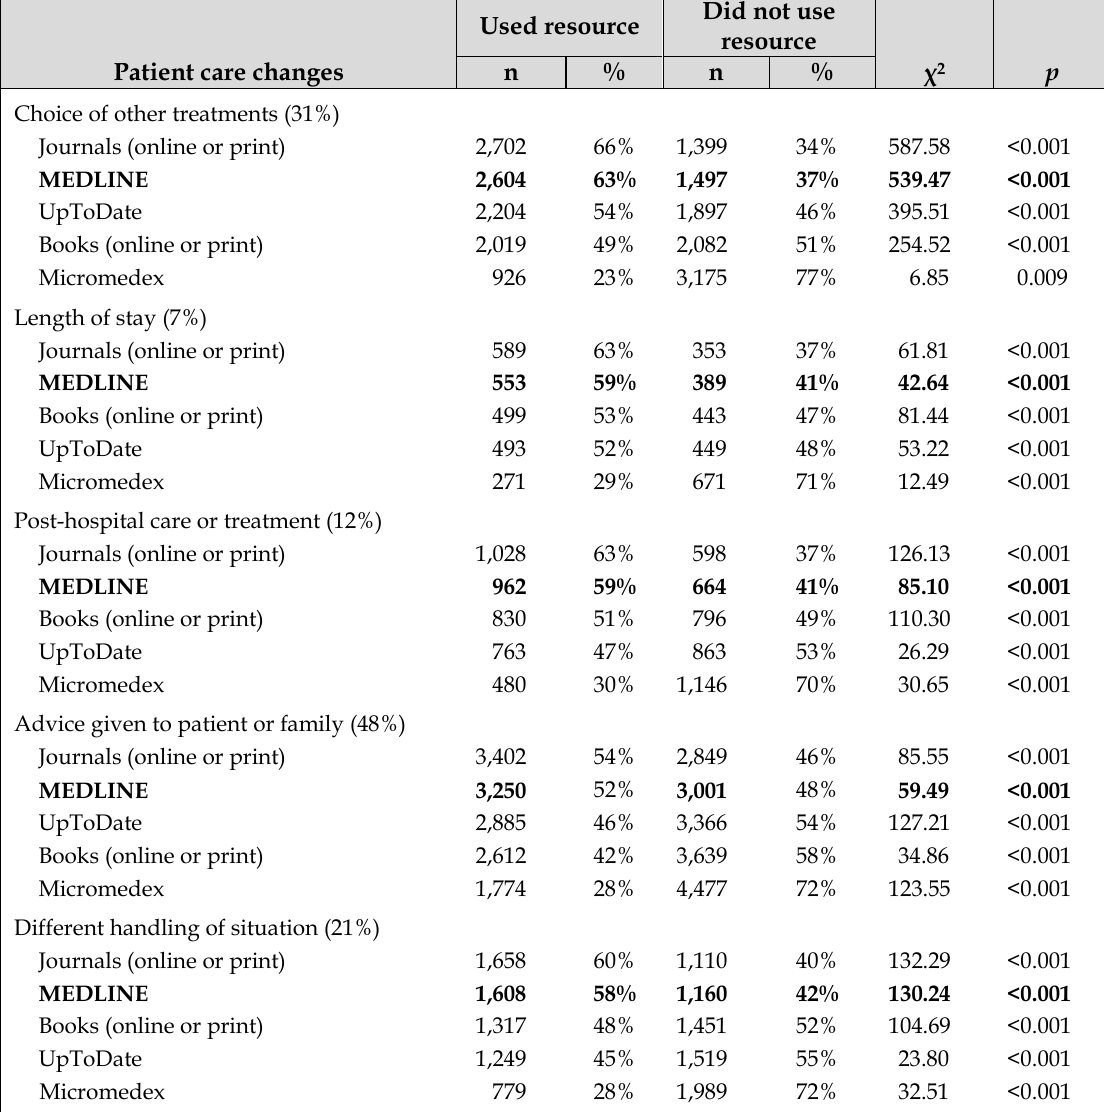
Table 2 Percent of respondents who used each information resource among those who made changes to patient care as a result of the information obtained in their searches (continued)